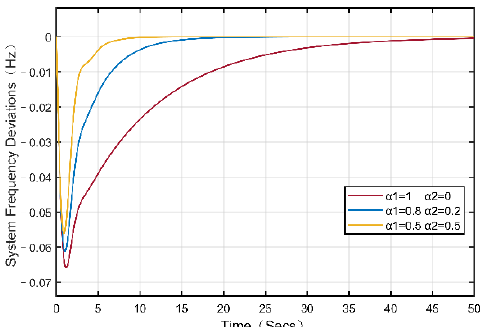
Figure 5. Comparison of the system frequency response contributed by changing the EVs.